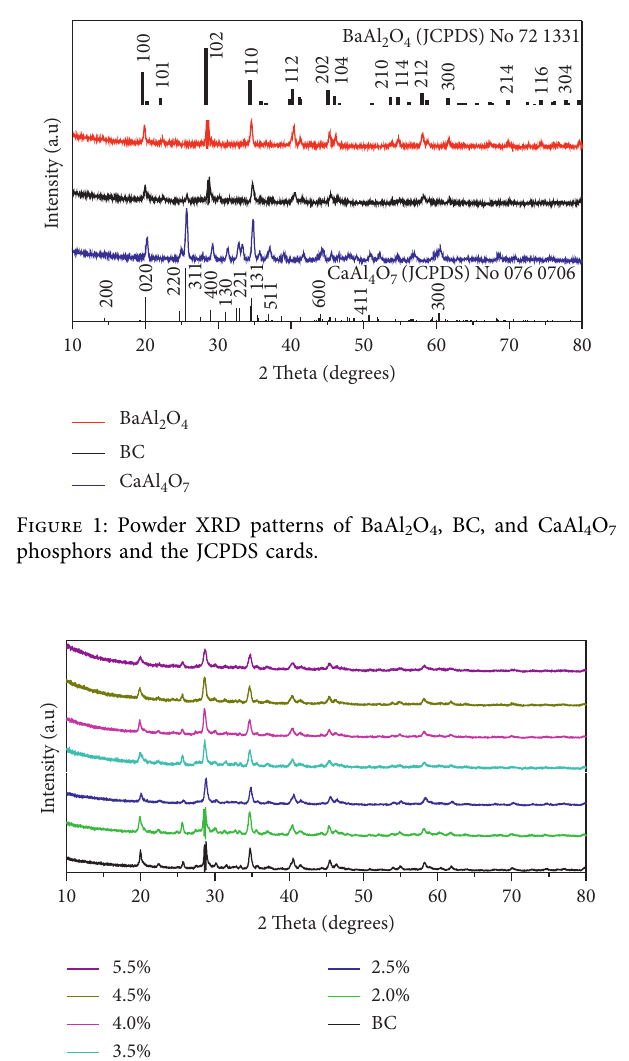
Figure 2: Powder XRD patterns of the BC: x % Eu 3+ (0 ≤ x ≤ 5.5)